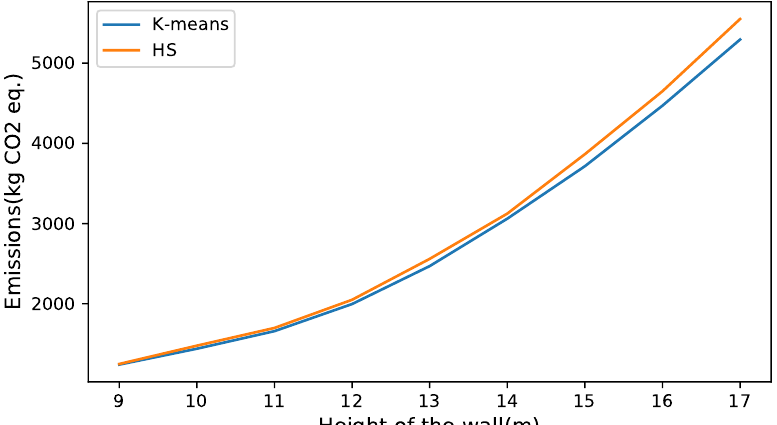
Figure 12. Comparison between the best solutions obtained by the k-means and HS algorithms in emission